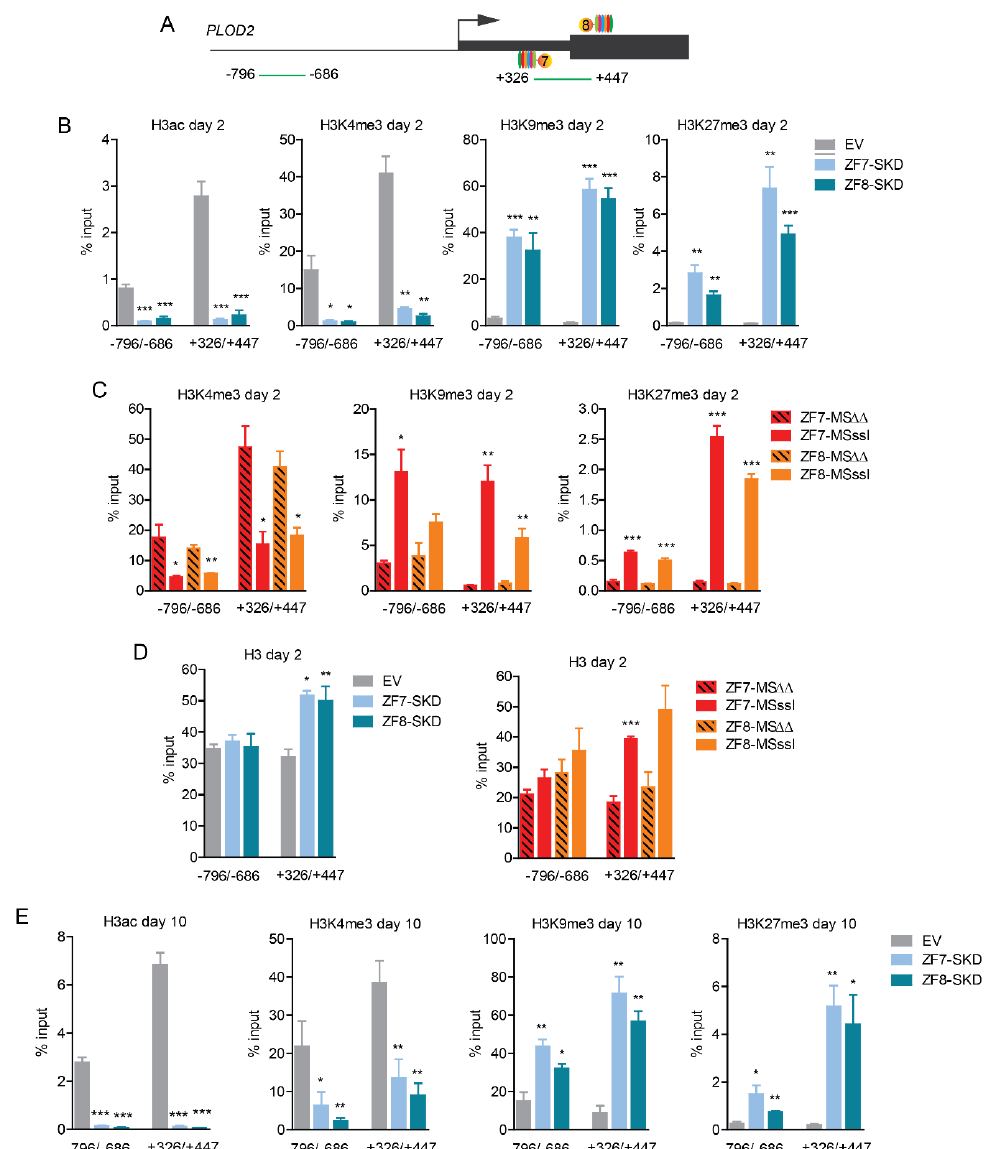
modifications H3ac and H3K4me3, and an increase of the repression-related modifications H3K9me3 and H3K27me3 were observed at the target region (from + 326 to + 447), as well as at the − 796 to − 686 bp upstream region (Figure 3B). Targeting M.SssI by the zinc fingers ZF7 and ZF8 also reduced H3K4me3, and increased H3K27me3 and H3K9me3 levels at both regions compared to cells targeted with the catalytically-inactive M.SssI ∆∆ (Figure 3C).